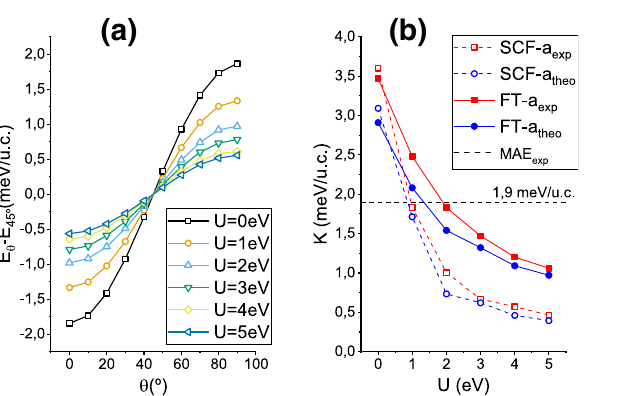
Figure 7. Néel temperature as a function of the U parameter obtained from: ( a ) the GMFT approximation (blue squares) and, ( b ) Monte Carlo simulations for the ES, TS, ED and TD calculation conditions. The horizontal exp dashed line indicates the experimental T N value in both panels. In ( a ) the blue dashed line is a linear fit to the data points. ( c ) Total magnetization of the unit cell normalized to that at T = 0 as a function of the system temperature in the Monte Carlo simulations. Data obtained from the ES exchange constants and for different U values. The Néel temperature, T N , in each case is indicated by the vertical lines.